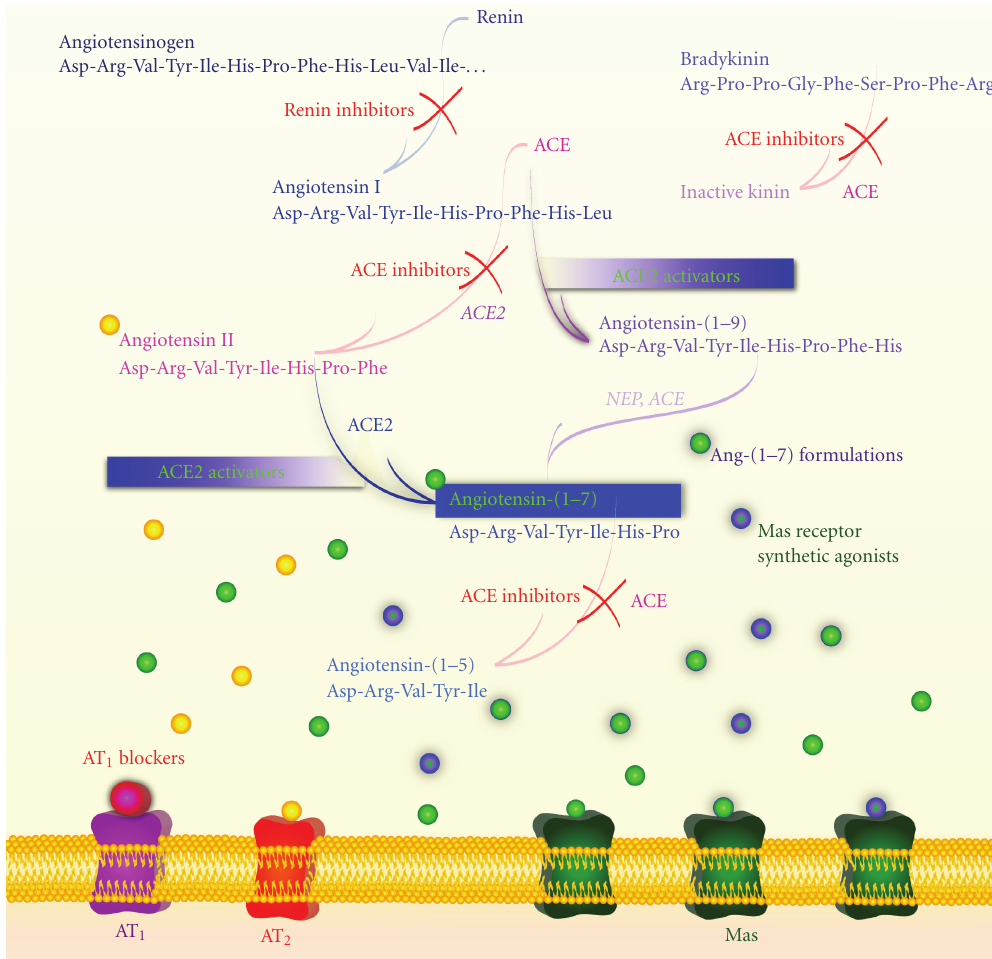
Figure 3: Schematic diagram showing the therapeutic strategies to modulate the activity of the renin-angiotensin system (RAS). In addition to the classical RAS blockers, that is, ACE inhibitors and AT 1 receptor blockers, the figure highlights the renin inhibitors, the Ang-(1–7) formulations [HP β CD/Ang-(1-7) and cyclic Ang-(1-7)], the synthetic Mas receptor agonists (AVE 0991 and CGEN-856S), and the ACE2 activator (XNT). ACE: angiotensin-converting enzyme; AT 1 : Ang II type 1 receptor; AT 2 : Ang II type 2 receptor; Mas: Ang-(1–7) receptor; NEP: neutral-endopeptidase